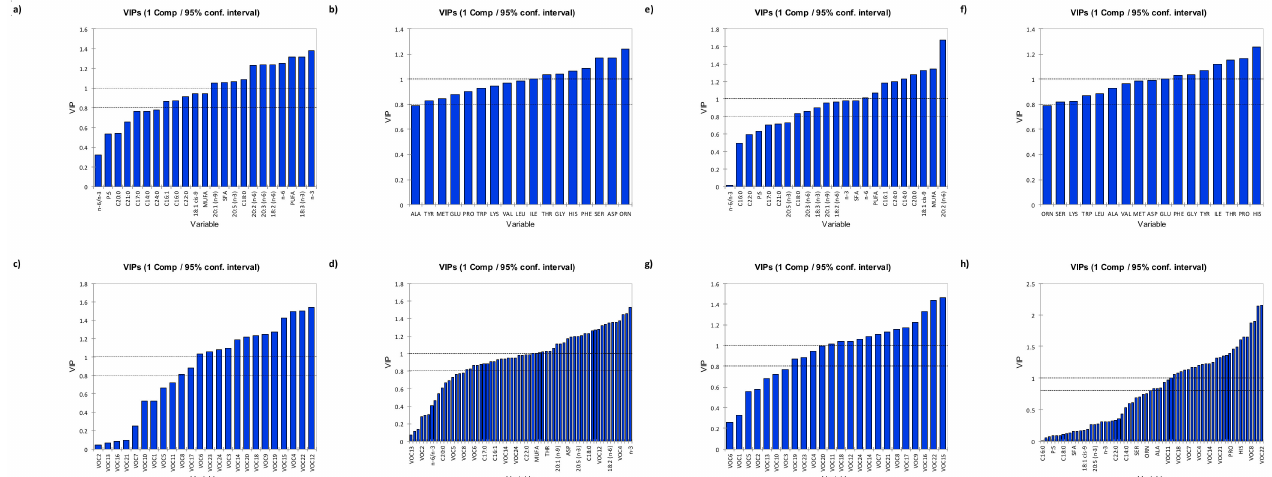
Figure 5. ( a – d ). Variable importance in the projection (VIP) for each variable in the partial-least-squares regression (PLSR) models arising from analysis of PEF treated fresh lamb samples in terms of ( a ) fatty acids, ( b ) amino acids, ( c ) volatile composition; ( d ) fatty acids, amino acids, and volatile composition were examined in relation to sensory attributes. ( e – h ) VIP for each variable in the PLSR models arising from analysis of PEF treated frozen lamb samples in terms of ( a ) fatty acids, ( b ) amino acids, ( c ) volatile composition; ( d ) fatty acids, amino acids, and volatile composition were examined in relation to sensory attributes. VOC codes for Figure 5a–d correspond to Supplementary Table S2 for chilled samples, and codes in Figure 5e–h correspond to Supplementary Table S3 for frozen